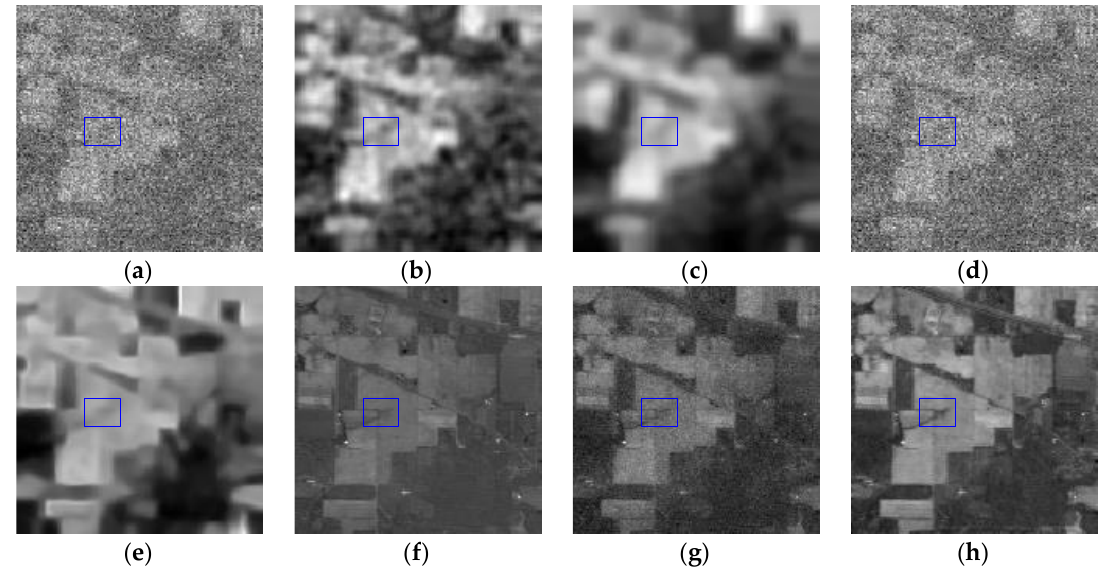
Figure 19. Restored results in Indian Pines image: ( a ) Original band 220; ( b ) KSVD; ( c ) BM3D;